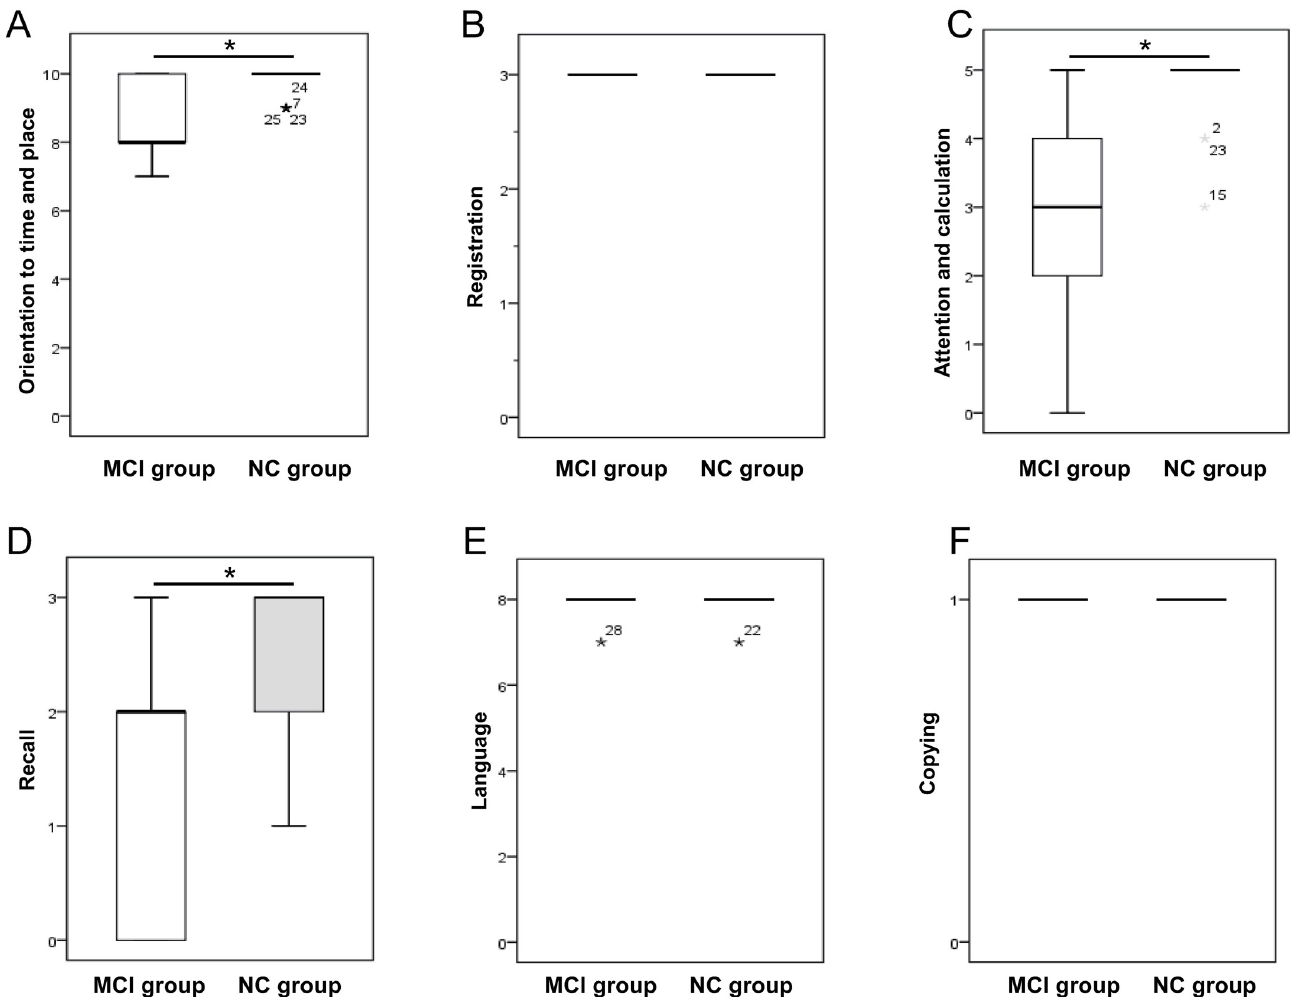
Fig 2. Distribution of MMSE scores for orientation to time and place, registration, attention and calculation, recall, language, and copying in the MCI and NC groups. Distribution of orientation to time and place (A), registration (B), attention and calculation (C), recall (D), language (E), and copying (F). MCI, mild cognitive impairment; MMSE, Mini-Mental State Examination; NC, normal